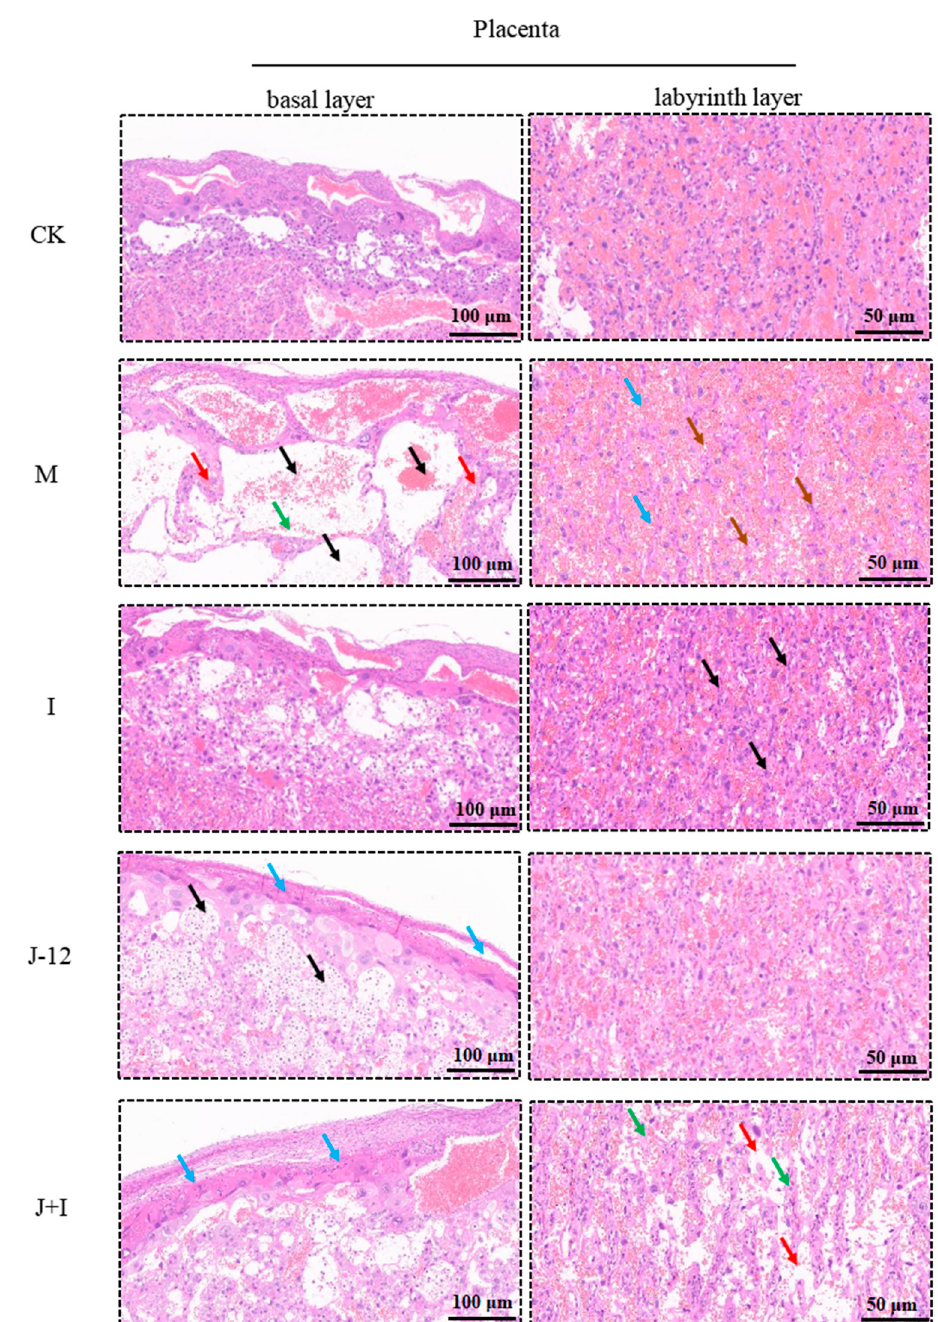
Figure 7. J-12 reduced placental tissue damage in rats with hyperglycemia in pregnancy. H&E staining in placental sections. M group: Cystic degeneration of glycogen cells is indicated by the black arrow, and edema and degeneration of sponge trophoblast cells are indicated by the green and red arrow, respectively, in the basal layer. Villi atrophy and fragmentation are indicated by the blue arrow, and fetal vascular reduction is indicated by the brown arrow in labyrinth layer. I group: fetal vascular reduction as indicated by the black arrow in the labyrinth layer. J-12 group: Glycogen cells are indicated by the black arrow, and cytolysis of giant cells is indicated by the blue arrow in the basal layer. J + I group: Cytolysis of giant cells is indicated by the blue arrow, and edema of sponge trophoblast cells is indicated by the brown arrow in basal layer. Villi fragmentation is indicated by the blue arrow, and aqueous degeneration of trophoblasts is indicated by the green arrow in the